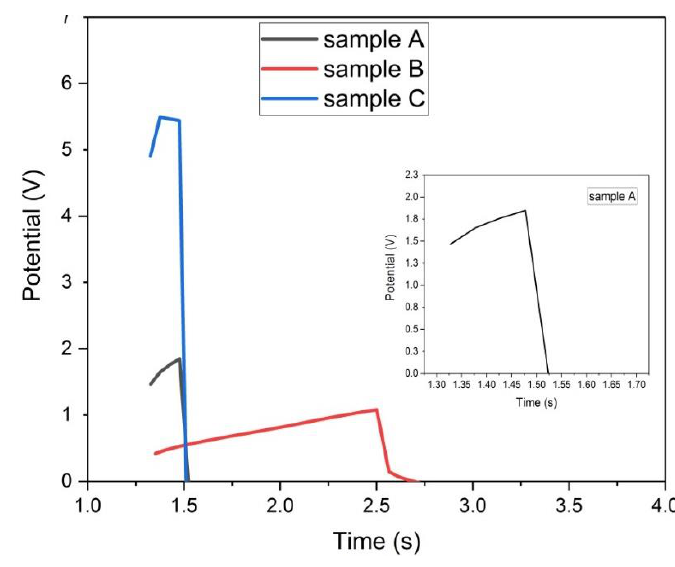
Figure 20. Galvanostatic charge-discharge plots of samples (A, B, and C) at 50 mA / g.